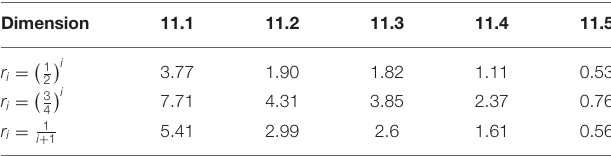
TABLE 4 | Capabilities for dimension 11 “ICT connectivity ” with growing effort (more complexity at higher stages). Dimension 11.1